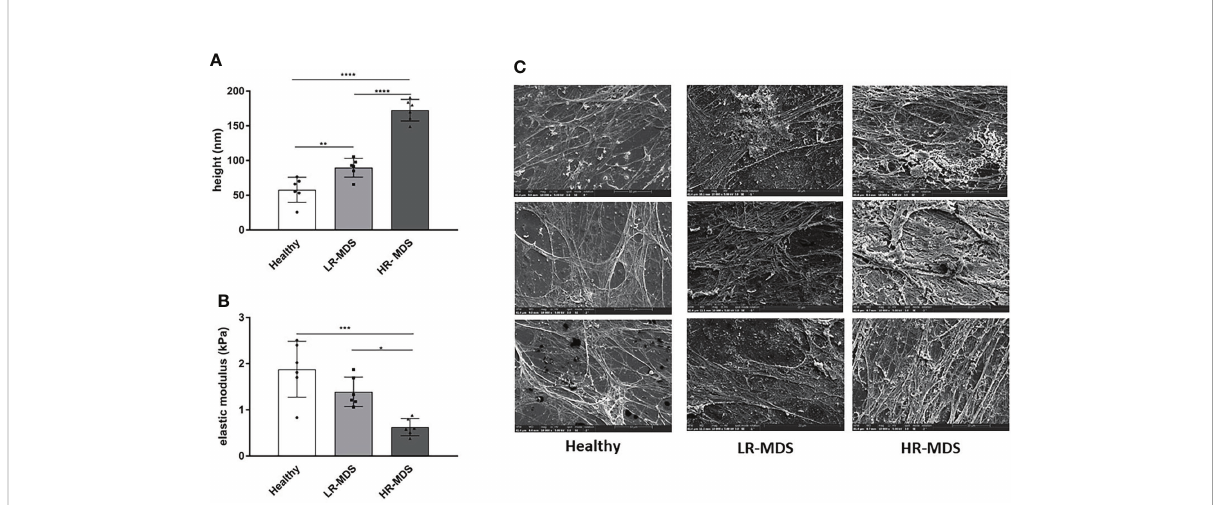
FIGURE 1 Ultrastructural ECM analyses. (A) Height and (B) elastic modulus measurement of ECM from healthy donor, LR-MDS and HR-MDS MSC. Bars represent mean ± SD in triplicate for N=3 samples per group. *p< 0.05, **p< 0.01, ***p< 0.001, ****p< 0.0001, analyzed by one-way ANOVA. (C) Representative electron micrographs for each sample group,